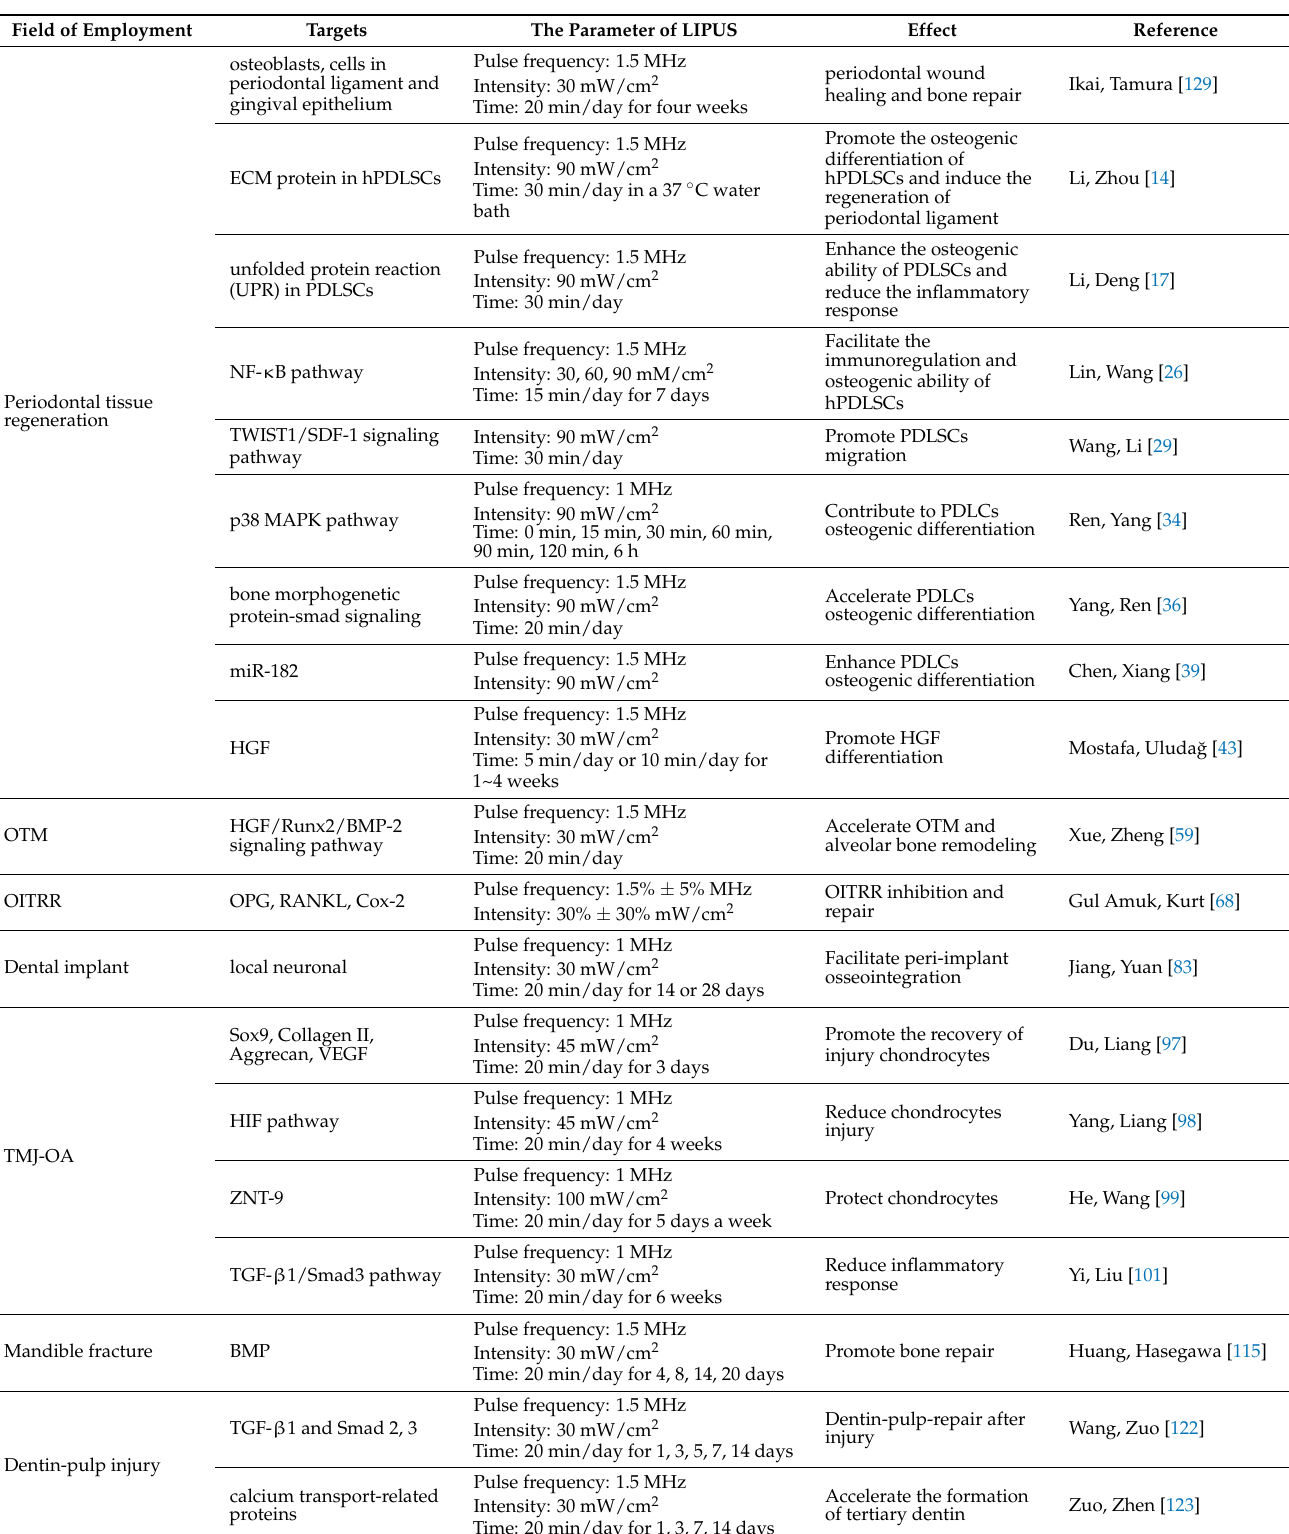
Table 1. Targets, parameters, and effects of LIPUS in oral